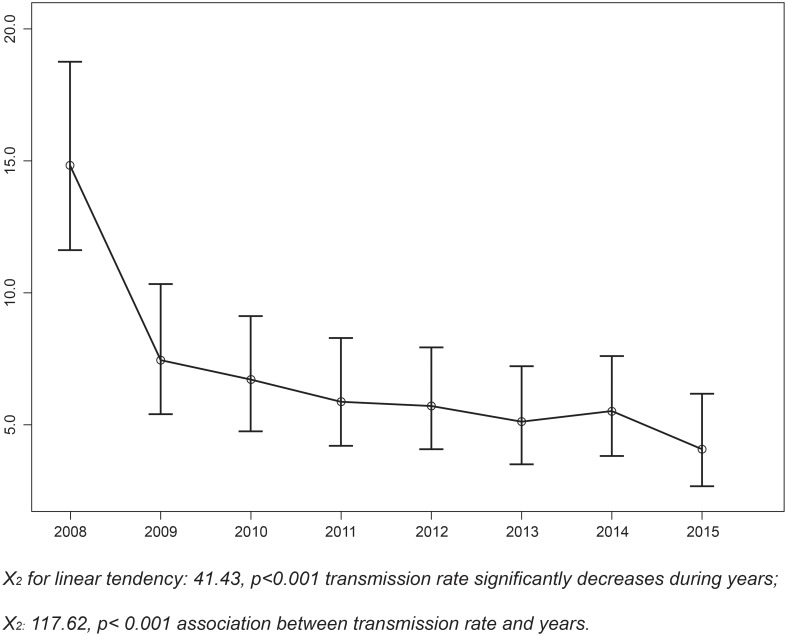
MTCT rate (%) between 2008 and 2015.X2 for linear tendency: 41.43, p<0.001 transmission rate significantly decreases during years; X2: 117.62, p< 0.001 association between transmission rate and years.